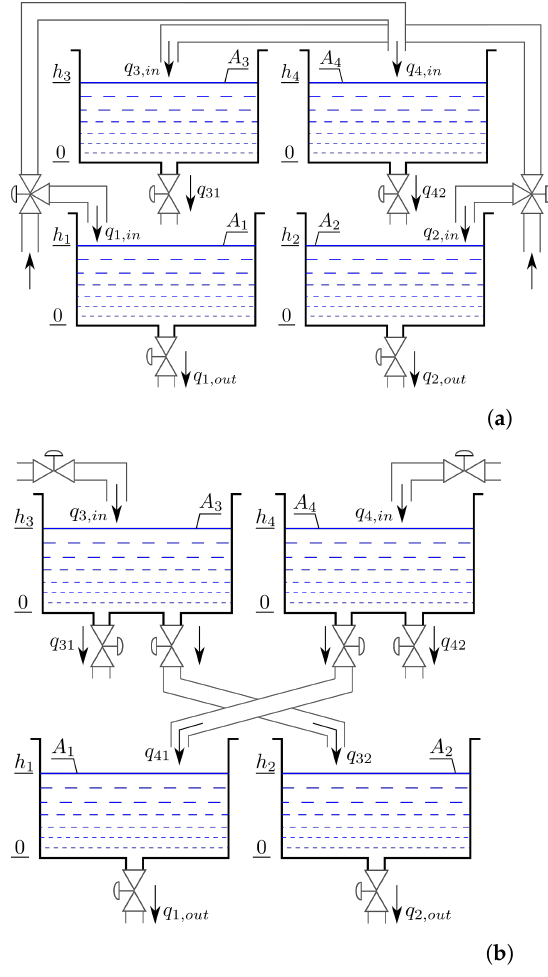
Figure 5. A physical model of the quadruple-tank system. ( a ) Four control inlets and two outlets, see [10,78,80,84]. ( b ) Two control inlets and two outlets, see